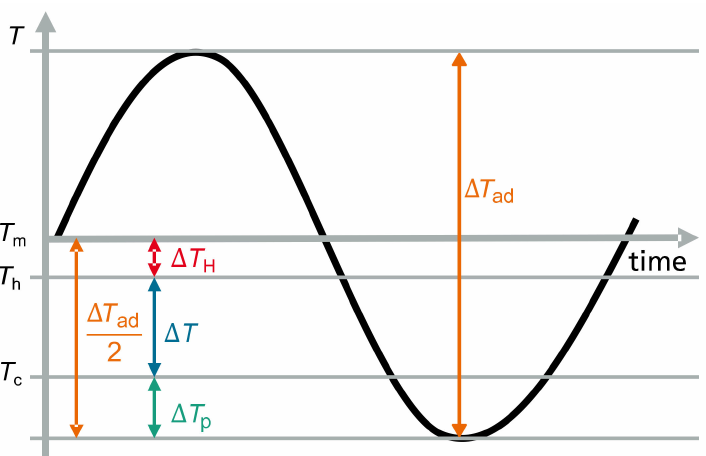
∆ T is made up ad 2